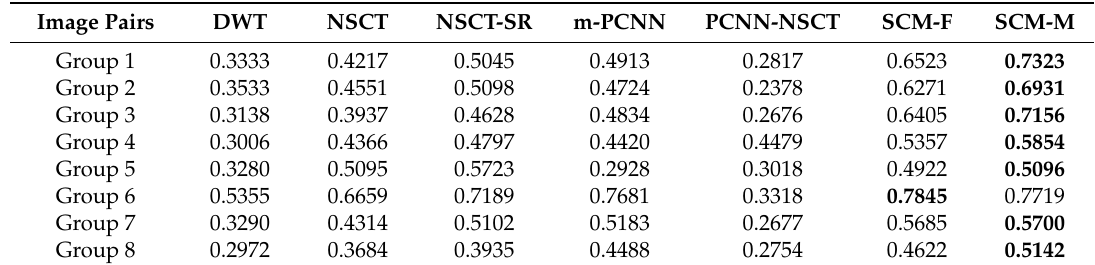
Table 4. Q L for the seven methods operating on the eight groups of medical images.